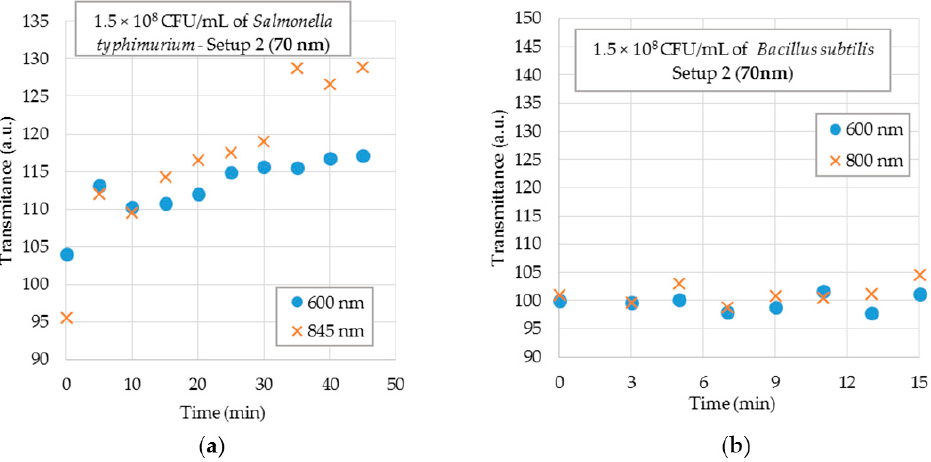
Figure 12. Sensor responses for 70 nm gold-coated probe for selectivity testing in a 1.5 × 10 8 CFU/mL bacteria concentration with Setup 2 for 600 nm and 845 nm wavelengths. ( a ) Salmonella typhimurium ; ( b ) Bacillus subtilis .